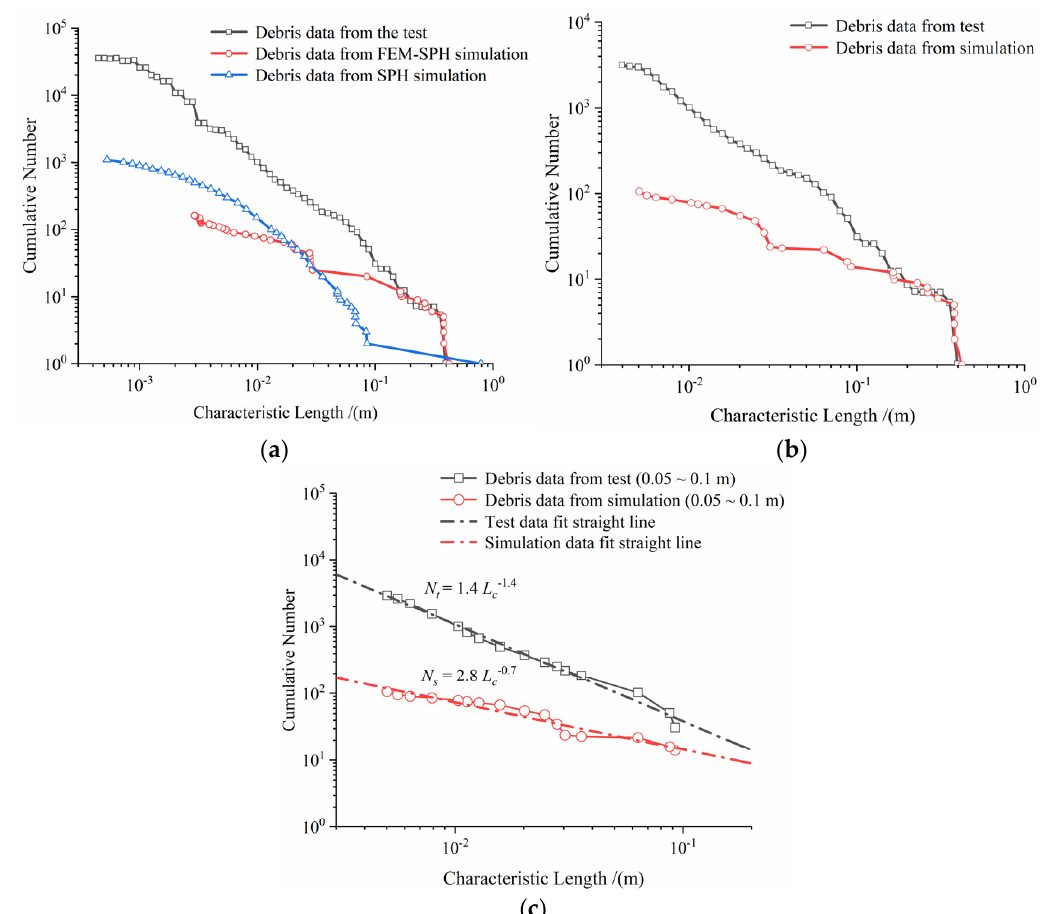
Figure 28. Comparison of fragment characteristic length distribution of the simulated satellite between simulation and test. ( a ) Comparison of fragment characteristic length distribution between the two simulation methods and test data; ( b ) comparison of characteristic length distribution between results of the finite element method-smooth particle hydrodynamics method and test data; ( c ) comparison of fitting lines between results of the finite element method-smooth particle hydrodynamics method and test data.